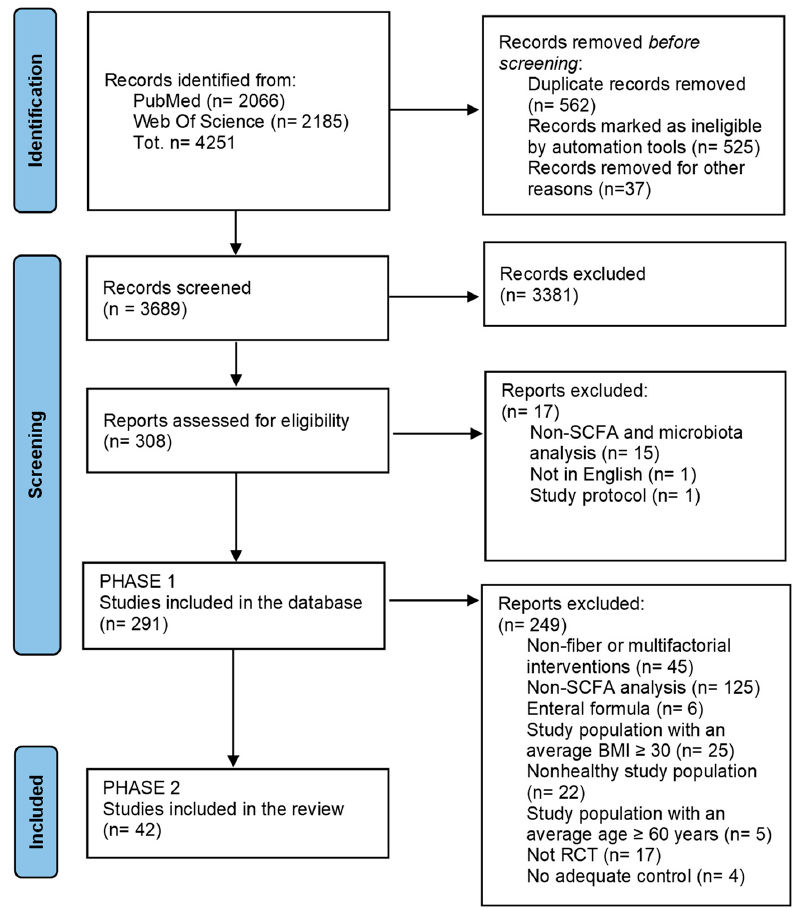
Figure 1. Flow diagram of studies included in the database (Phase 1) and in the systematic review (Phase 2) (PRISMA diagram).